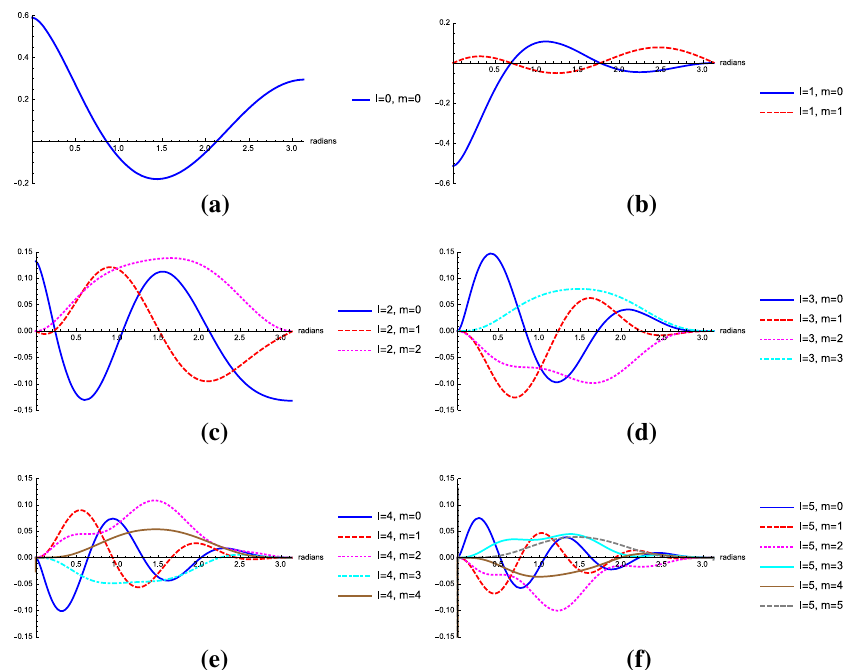
Fig. 46 Spherical harmonic component functions γ lm (ζ) for pulsar timing as a function of the angle ζ between two distinct pulsars. Here we show plots for l = 0 , 1 ,..., 5 and m ≥ 0. We used the Earth-term- only Doppler-frequency response (5.21) to calculate these